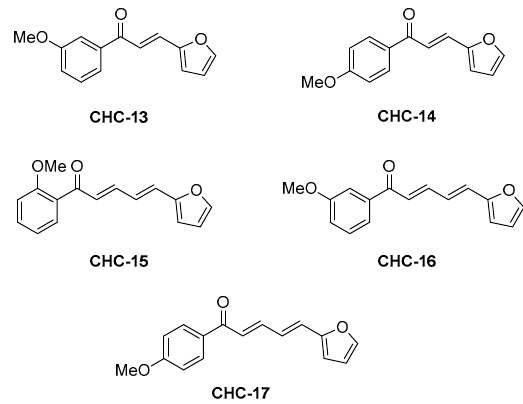
Figure 13. Chemical structures of CHC-13-CHC-17.